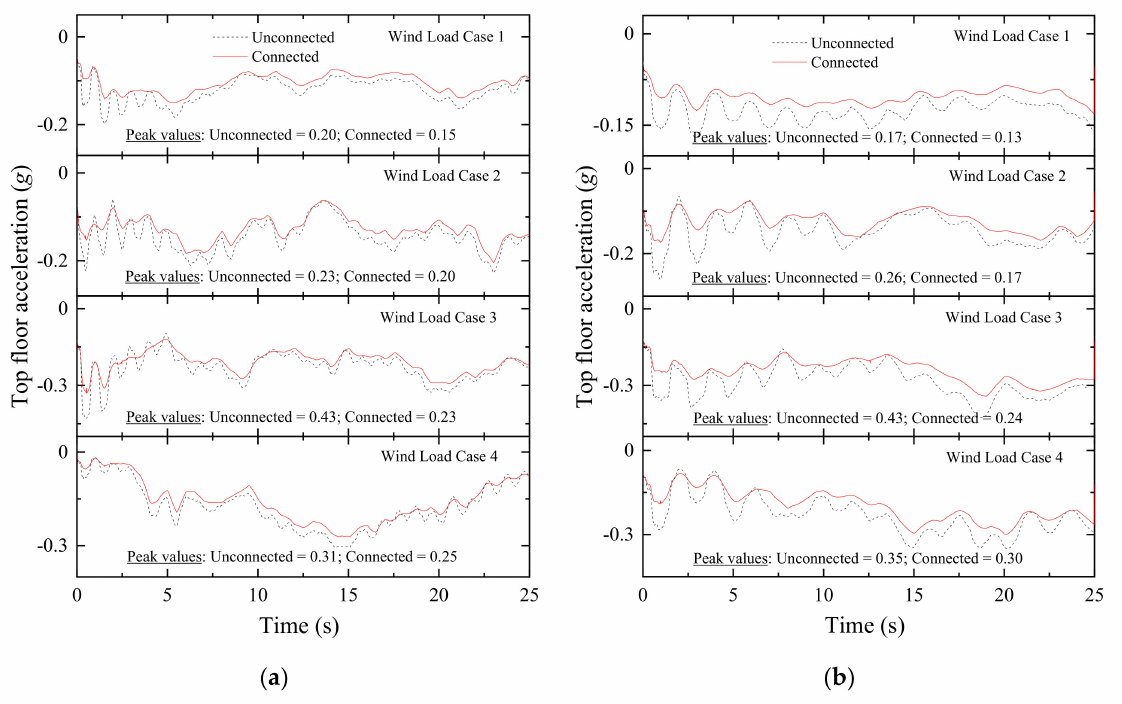
Figure 27. Time history of top floor acceleration under wind excitation in: ( a ) a coupled stiff building and ( b ) a coupled flexible building when semi-active MR dampers are used as coupling devices in Configuration